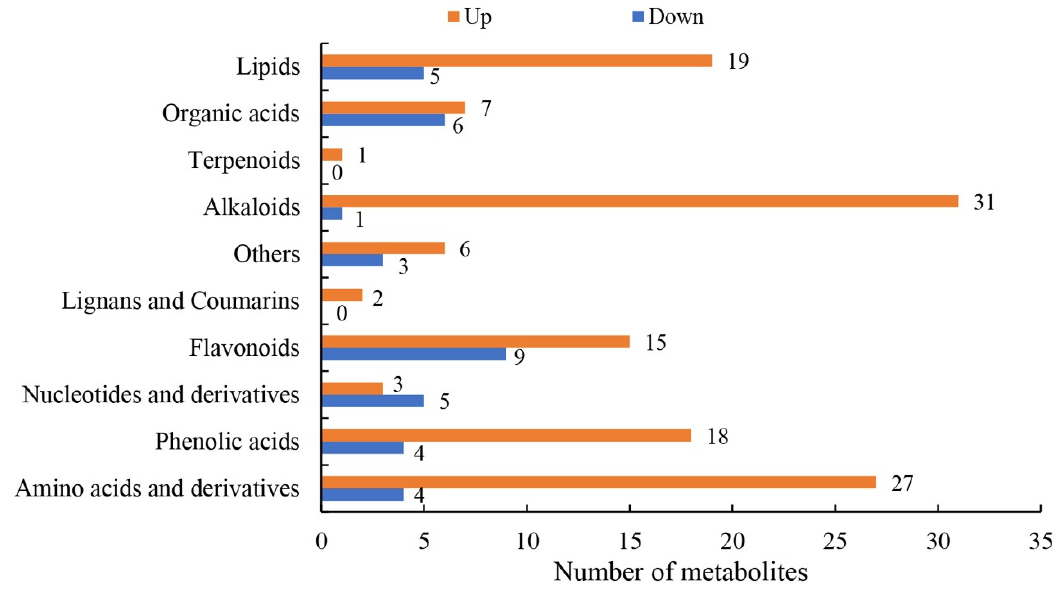
Figure 6. Classification of significantly regulated metabolites (SRMs).